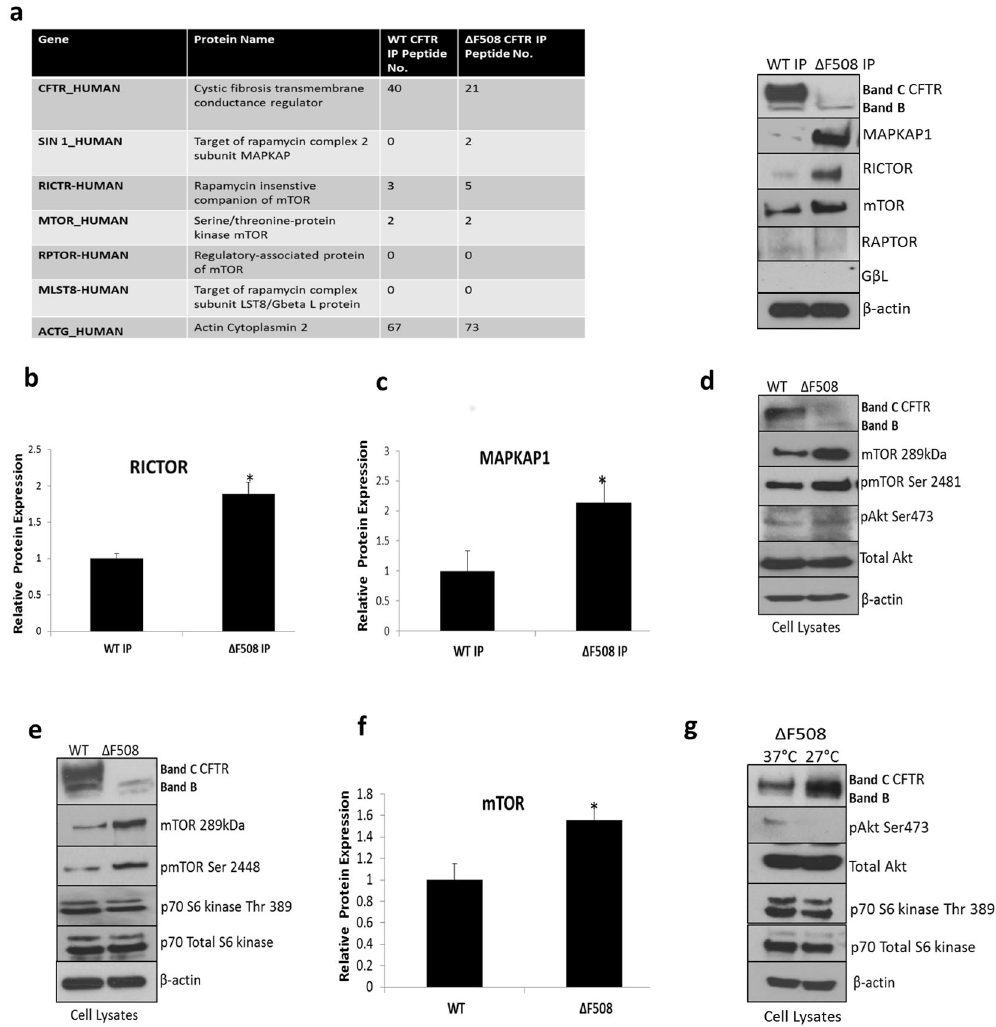
Figure 2. PI3K/AKT/mTOR signalling molecules associate with Δ F508 CFTR interactome. ( a ) CFTR was immunoprecipitated from WT HBE41o- and Δ F508 CFBE41o- cells and immunoblotting was performed for mTORC1/2 components, RICTOR, RAPTOR, mTOR, MAPKAP1 and G β L as well as CFTR and β -actin to confirm mass spectrometry observations (table left). A quantitative graph of ( b ) RICTOR and ( c ) MAPKAP1 in WT and Δ F508 CFTR immunoprecipitates. The results shown are representative of three independent experiments; the histograms represent the average and the error bars represent the standard deviation of the means. Statistical significance was examined using unpaired T-test analysis. Asterisk * represents p < 0.05. ( d) Protein expression of mTOR, pmTOR Ser 2481, pAkt Ser 473 and total Akt (mTORC2) were determined by immunoblotting in WT HBE41o- and Δ F508 CFBE41o- cell lysates in addition to CFTR and β -actin. ( e ) Protein expression of mTOR, pmTOR Ser 2448, p70 S6 kinase Thr 389 and total 70 S6 kinase (mTORC1) were determined by immunoblotting in WT HBE41o- and Δ F508 CFBE41o- cell lysates in addition to CFTR and β -actin. ( f ) A quantitative graph of mTOR from WT HBE41o- and Δ F508 CFBE41o- cell lysates, the results shown are representative of three independent experiments; the histograms represent the average and the error bars represent the standard deviation of the means. Statistical significance was tested by unpaired T-test analysis. Asterisk * represents p < 0.05 ( g ). Protein expression of pAkt Ser 473, p70 S6 kinase Thr 389, Akt and p70 S6 kinase were determined by immunoblotting in Δ F508 CFBE41o- (37 °C) and Δ F508 CFBE41o- cells temperature shifted to 27 °C in addition to CFTR and β